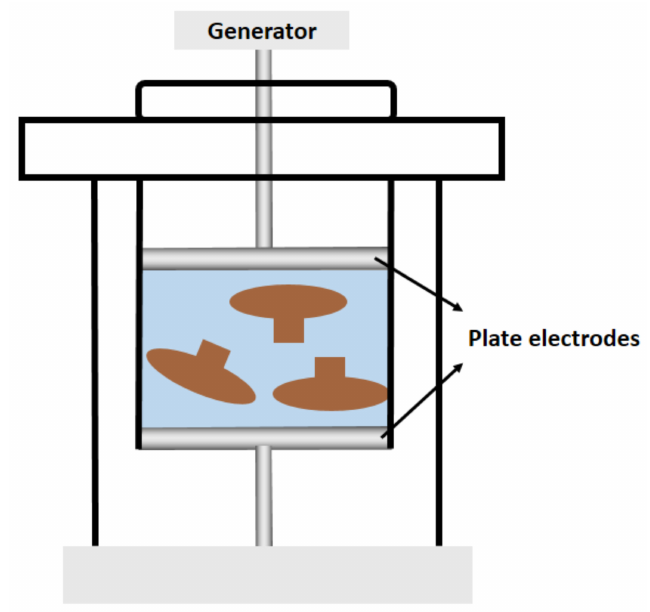
Figure 5. EFP extraction by